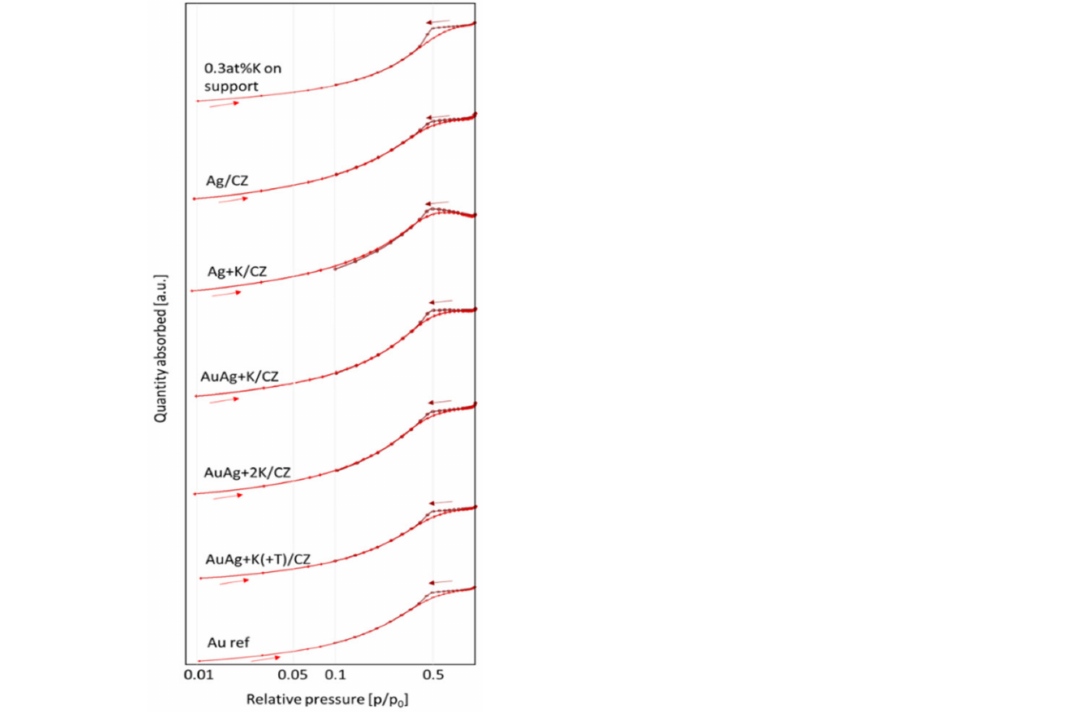
Figure 3. N 2 adsorption/desorption isotherms of the support doped with potassium ions, the studied catalysts, and Au reference sample.